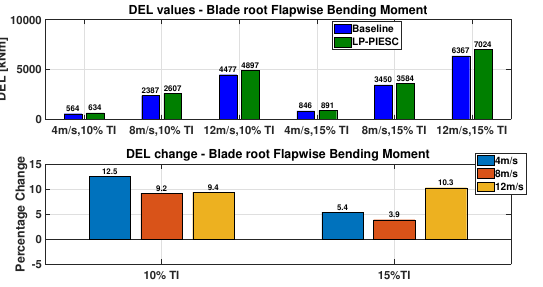
Figure 20. Blade-root flap-wise bending moment comparison: Baseline vs. LP-PIESC. Aggregate DEL values with baseline controller and LP-PIESC ( top ), percentage change in DEL ( bottom ) for time series from 150 s to 3000